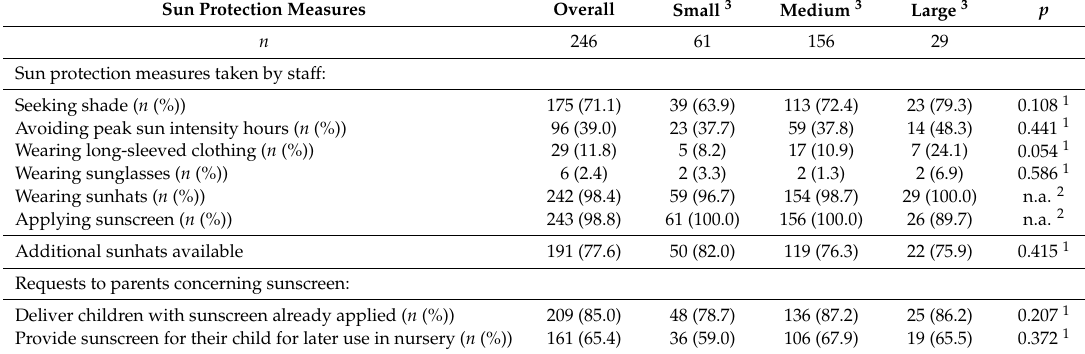
Table 2. Sun protection measures taken by the nursery staff during outdoor playtime and requests to parents concerning sunscreen in 246 nurseries in Bavaria, southern Germany.